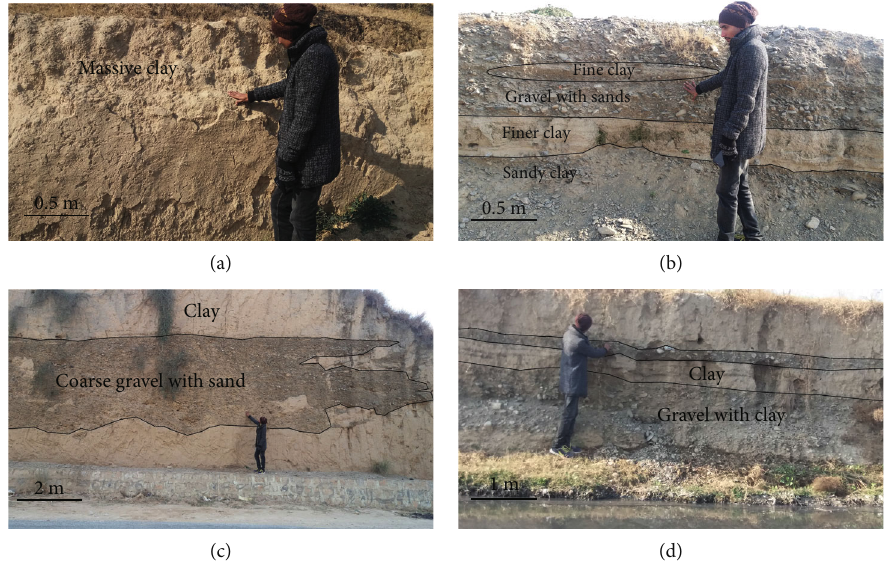
Figure 2: Geological features at four di ff erent locations across the Haripur basin. (a) Massive clay identi fi ed in the vicinity of Haripur city, (b) interbedded gravel and sand with fi ner clay and sandy clay identi fi ed across upstream areas of Hattar Industrial Estate, (c) thick succession of clay and coarse gravel with sand near khanpur, and (d) interbedded clay and gravel with sand in the Deedan village. The locations of the geological fi eld sites (a – d) are highlighted on the geological map presented in Figure 1.